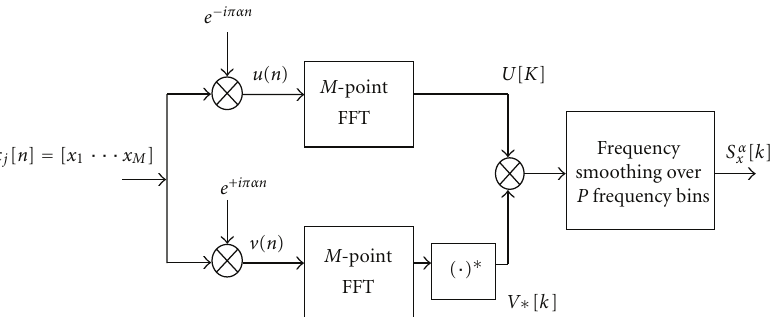
Figure 3: Cyclostationary feature detection